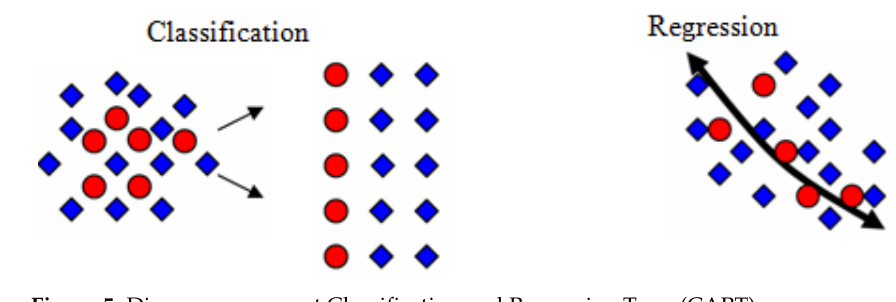
Figure 5. Diagrams represent Classification and Regression Trees (CART).